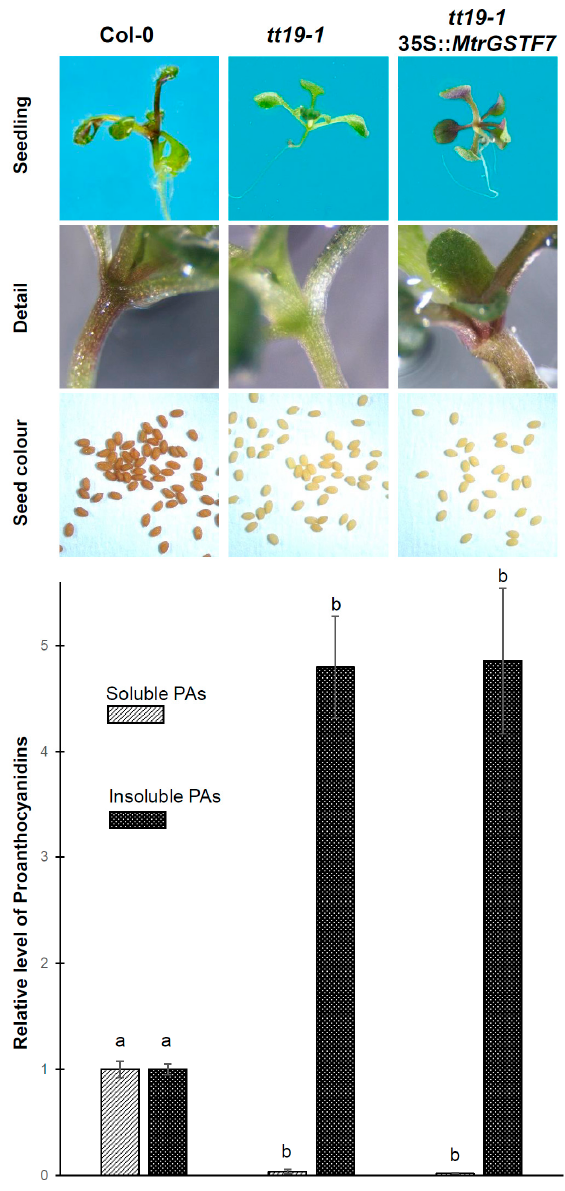
Figure 12. Functional complementation assay. From the top: seedlings; detail of anthocyanin colouration at the rosette base; seeds; relative content of soluble and insoluble PA in wt seeds vs. those from tt19-1 mutant and tt19-1 mutant transformed with the 35S:: MtrGSTF7 construct. Significant differences ( p < 0.05) as determined by Tukey’s multiple comparisons test are indicated with different letters.